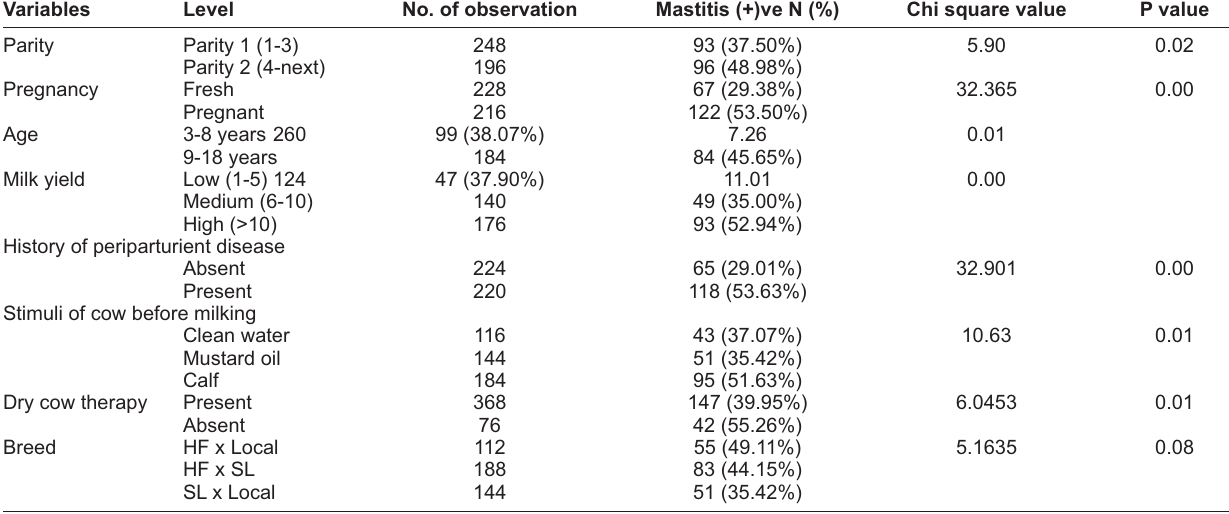
Table-3: Distribution of SCM at animal level in relation to different variables Variables